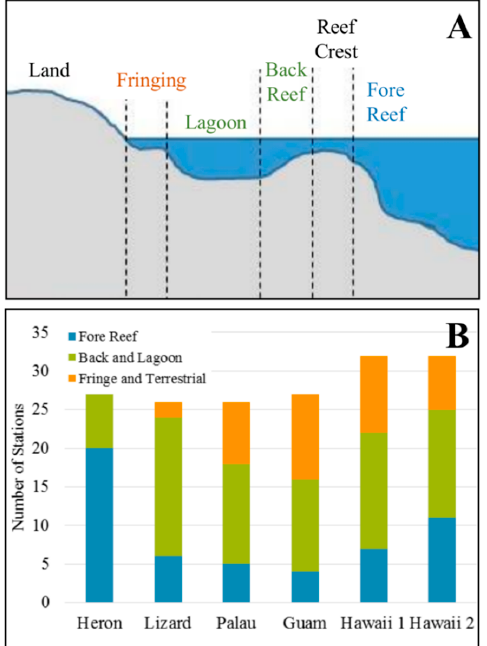
Figure 5. ( A ) A visual depiction of the different tropical coral reef zones going from the outer fore reef most influenced by oceanic water to the nearshore fringing and terrestrially impacted zone. ( B ) The number of stations sampled from each campaign with the three broad geomorphic zones color coded similarly to panel ( A ).